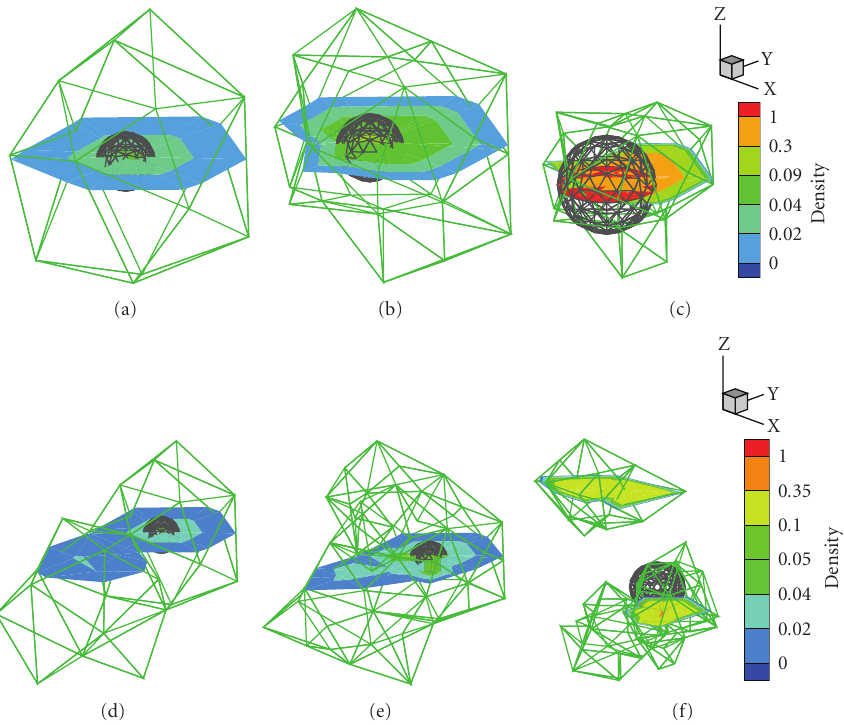
Figure 3: Mesh evolution in the single source case and the regularized solutions on di ff erent mesh levels. The green mesh denotes the local region around the regularized solution in PSR; the black sphere is the actual source. (a), (b), and (c) are the reconstruction by l 1 regularization in the first, the second, and the last level, respectively. (d), (e) and (f) are the corresponding results by l 2